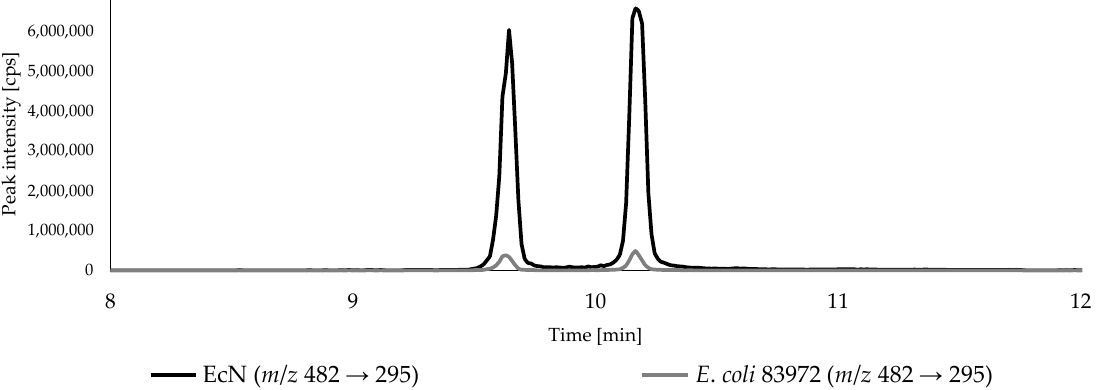
Figure 4. LC-MS / MS chromatogram of the culture supernatant of E. coli strains EcN and 83972, displaying the two isomers of Ybt with the mass spectrometric transition m / z 482 →